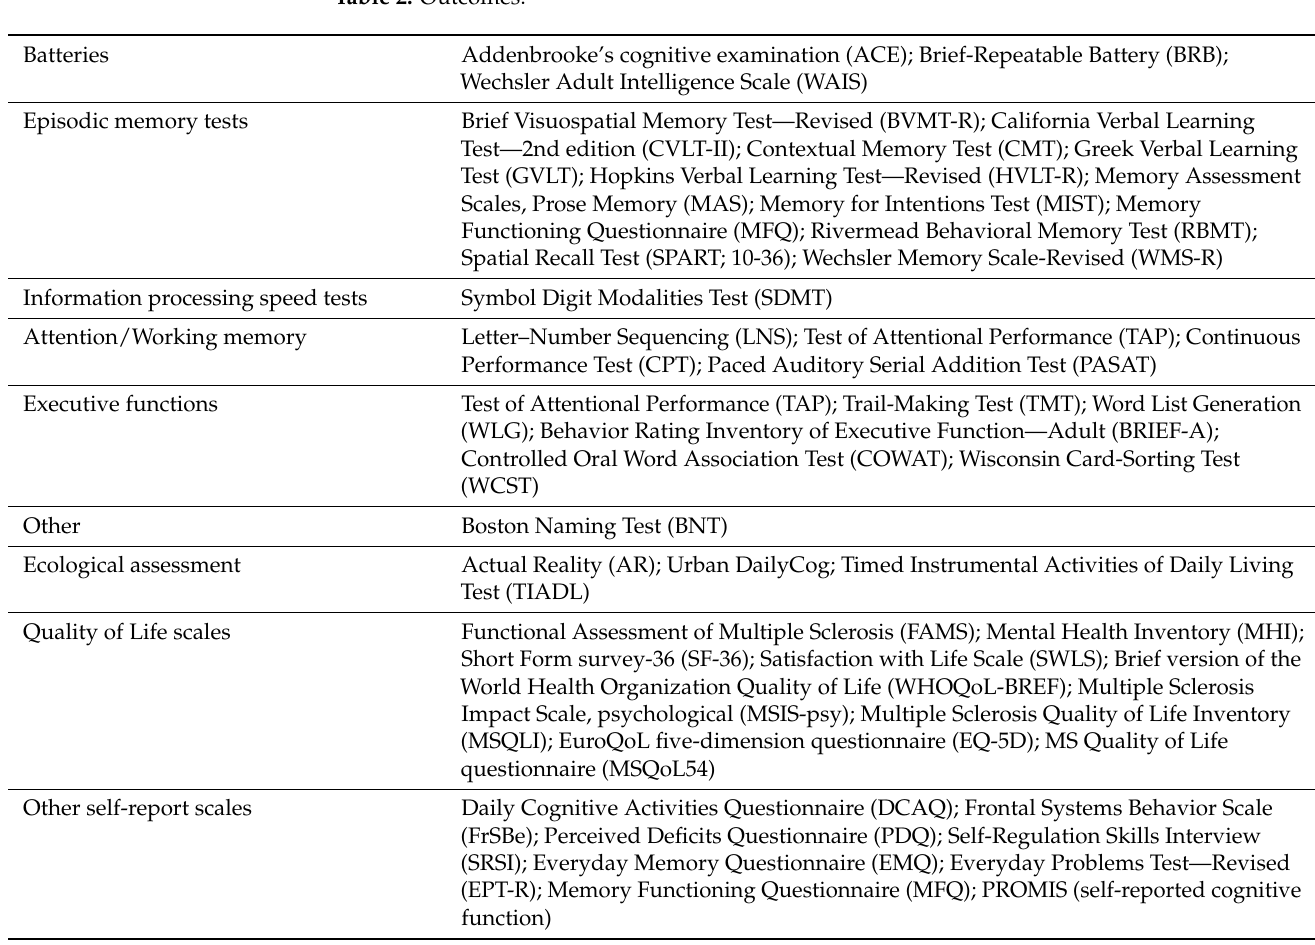
Table 2 summarizes the outcomes used in these studies. Table 2.